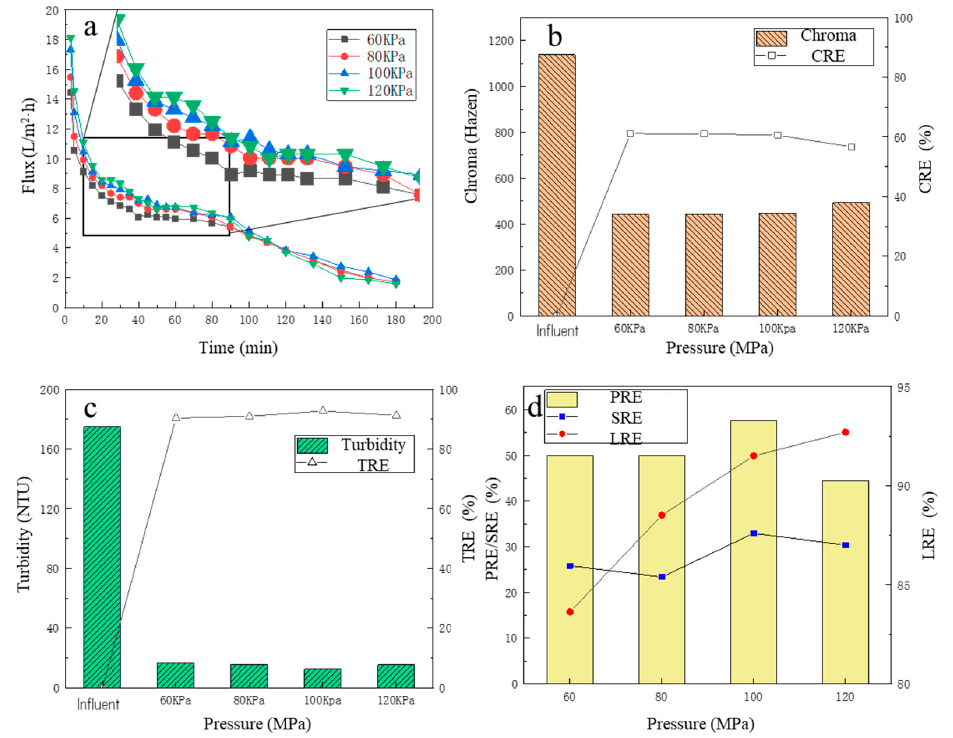
Figure 2. The effect of different pressures on filtration performance: ( a ) the flux change; ( b ) the chroma removal; ( c ) the turbidity removal; ( d ) the protein removal efficiency, the total sugar removal efficiency, and the lactic acid recovery efficiency .